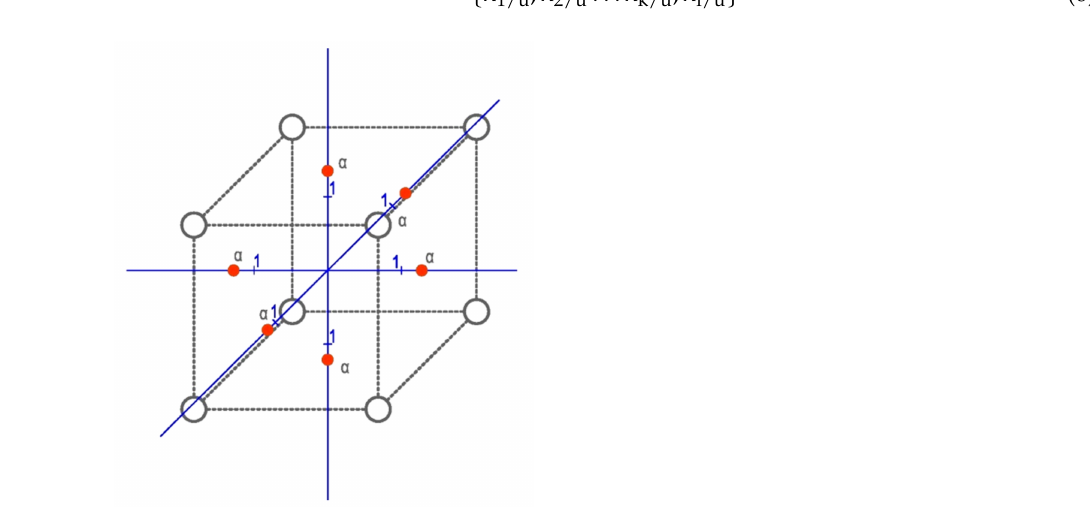
Figure 3. Graphical diagram of the stellar ray of an incomplete, polyselective, orthogonal plan experiment plan.